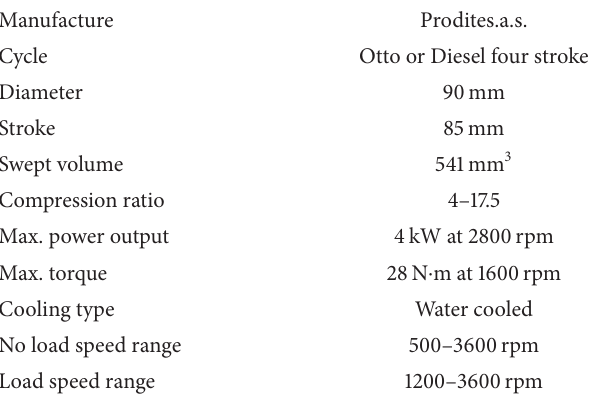
Table 1: Engine specifications.